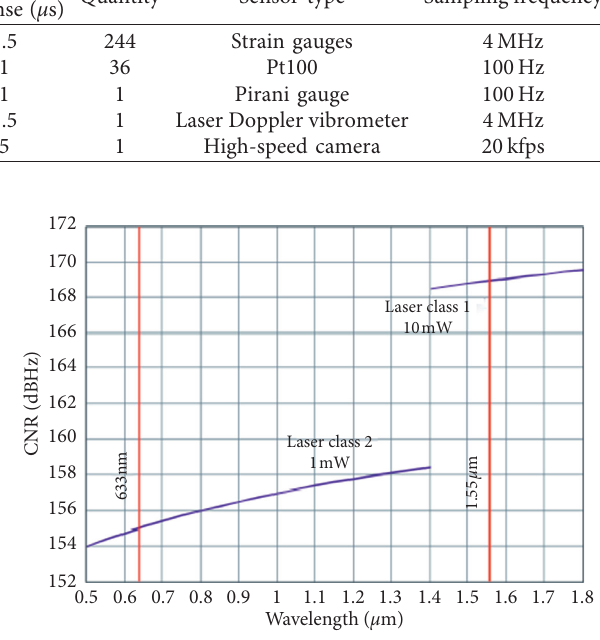
Figure 9: Theoretical carrier-to-noise ratio drawn over wavelength, with the measurement light power allowed for class 2 lasers for wavelengths up to 1 . 4 μ m and class 1 lasers for wavelengths above 1 . 4 μ m